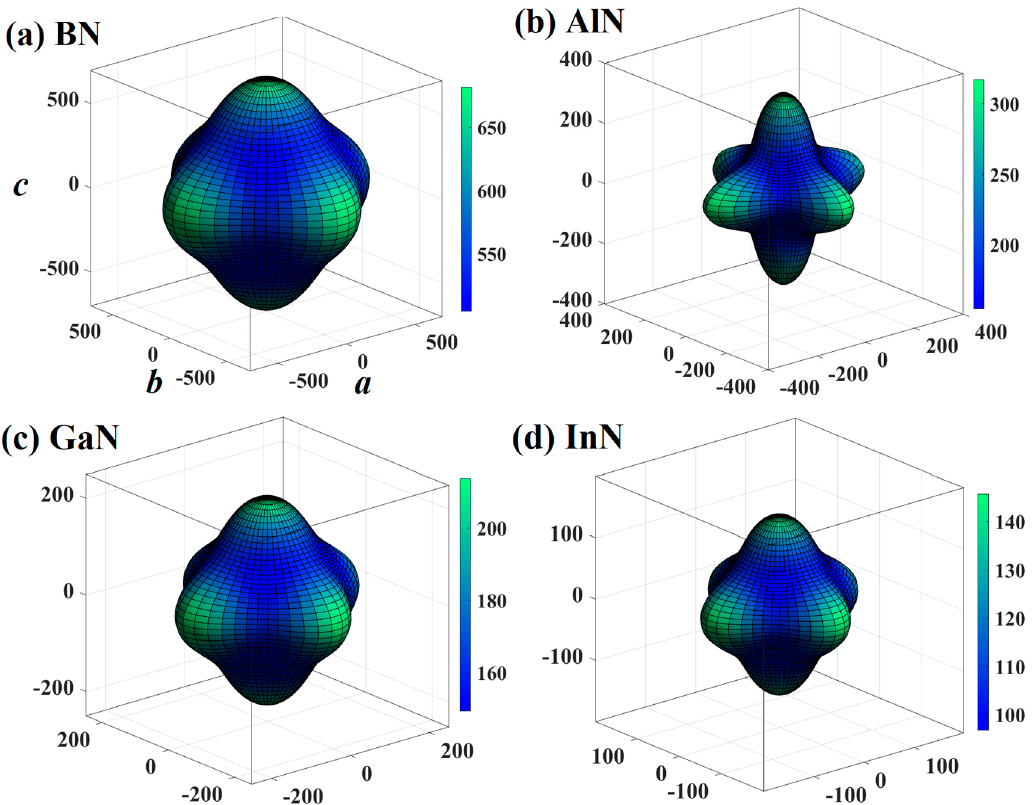
Figure 4. The three-dimensional contour plots of the Young’s modulus for BN ( a ), AlN ( b ), GaN ( c ), and InN ( d ) in the Pm −3 n phase.